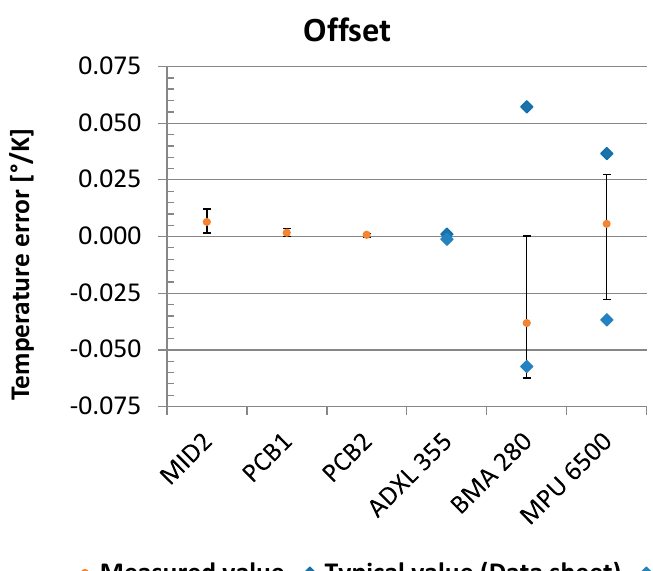
Figure 19. Temperature error sensor offset.